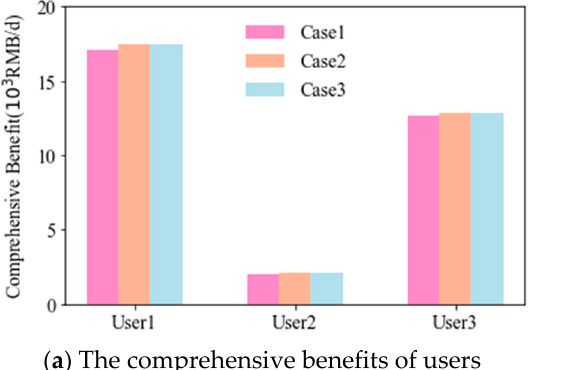
Figure 5. The benefits of users in summer.